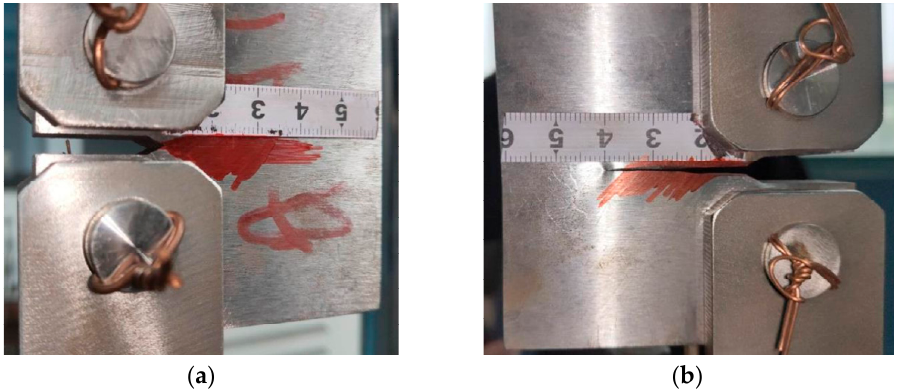
Figure 4. Fatigue crack propagation process. ( a ) Crack propagation initial stage; ( b ) Crack propagation close to fracture.